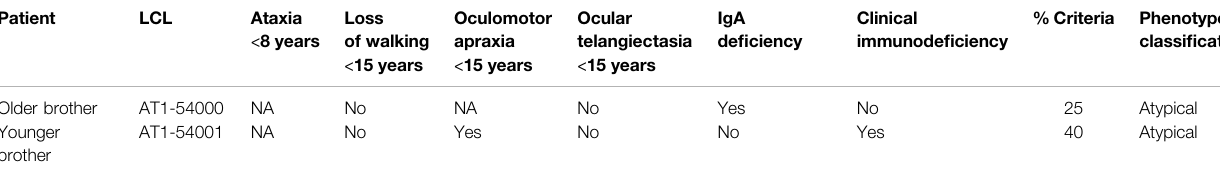
TABLE 1 | Phenotype classi fi cation according to Fievet et al., 2019.